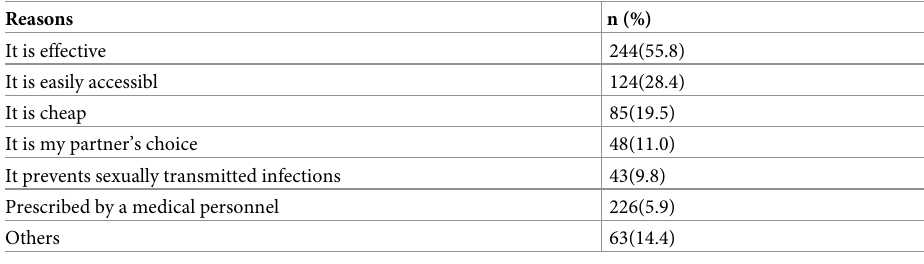
Table 2. Reasons explaining the current contraceptive choices (cid:3)(cid:3)